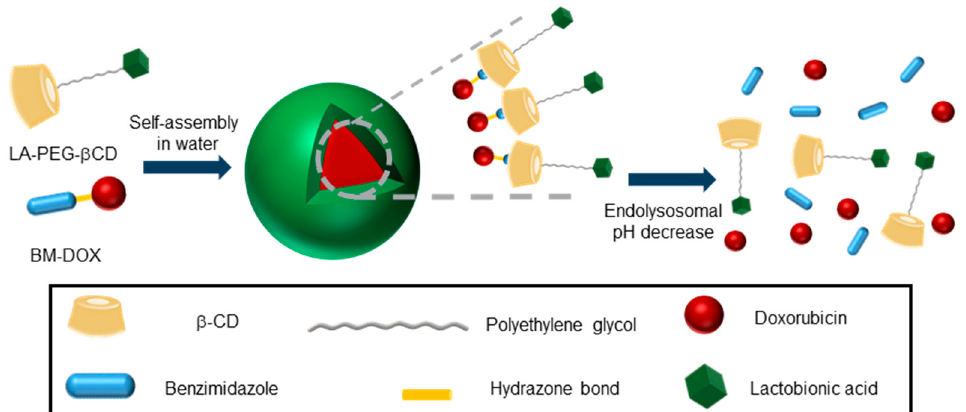
Figure 5. Schematic illustration of the superamphiphile strategy developed by Zhang and coworkers for the self-assembly of acid-sensitive ASGPR-targeted prodrug glyconanoparticles [46]. ASGPR, asialoglycoprotein receptor; LA, lactobionic acid; PEG, poly(ethylenglycol); β CD, β -cyclodextrin; BM, benzimidazole; DOX, doxorubicin.